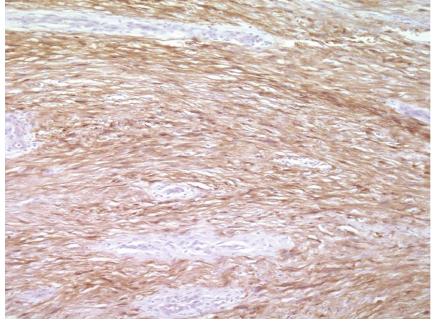
Figure 7: The tumor cells are positive for S-100 protein (immunos- taining of S-100 protein, ×